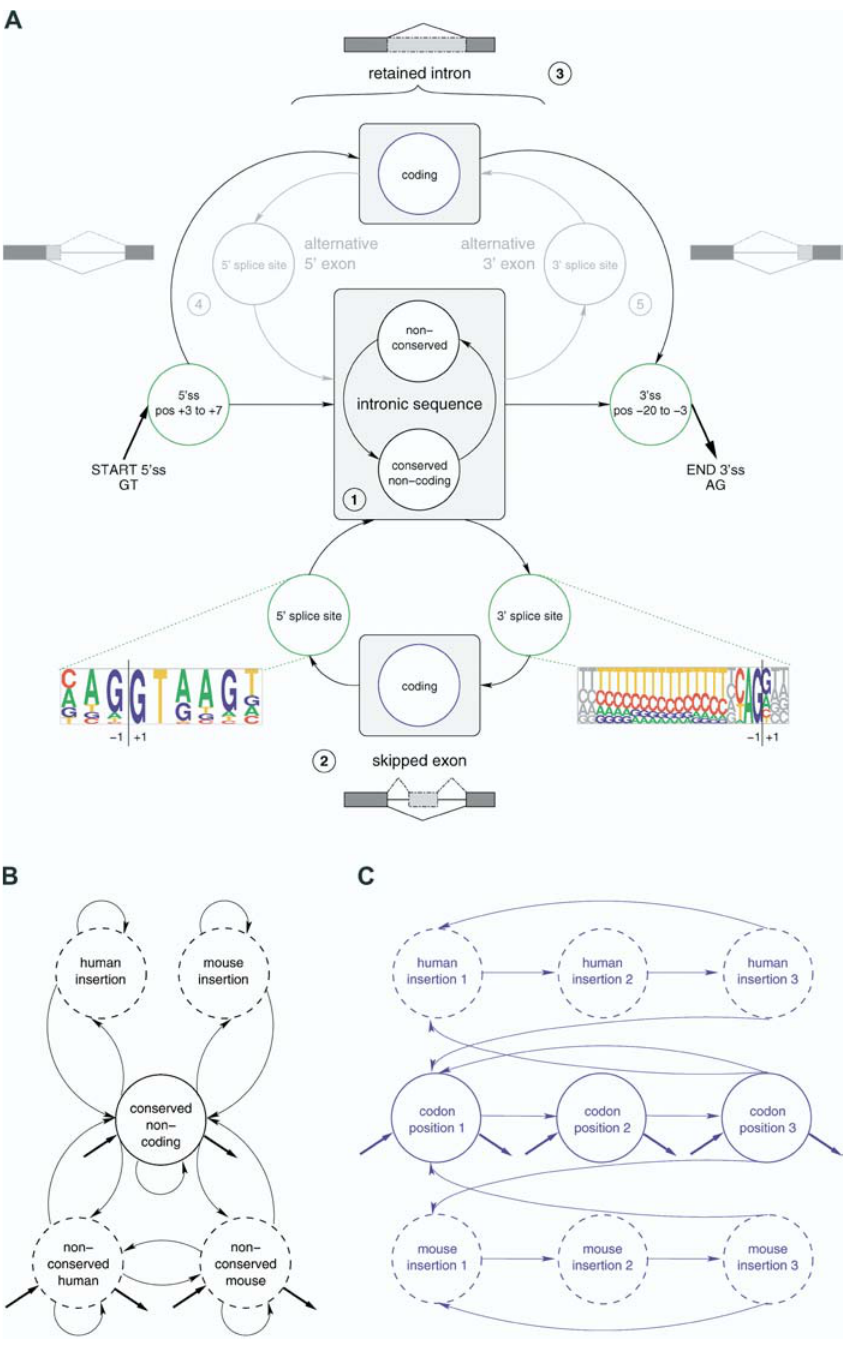
Figure 1. Structure of the UNCOVER